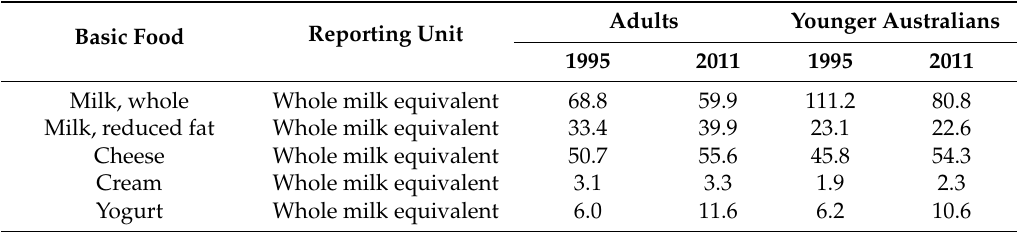
Table 5. Reported intake of selected dairy products (kg/person/year) by adult (19 years and above) and younger Australians (2 to 18 years) in 1995 and 2011. 1